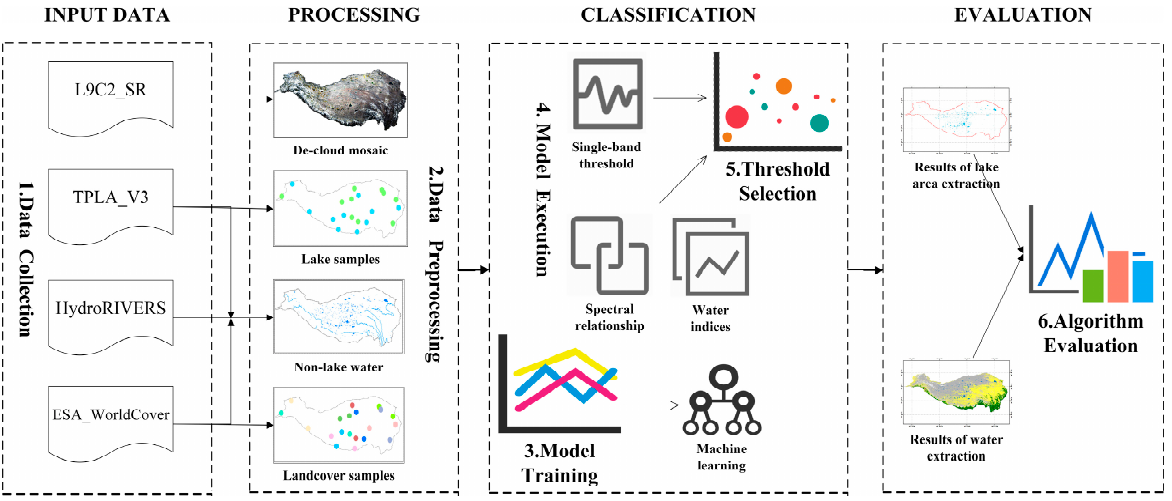
Figure 2. The general workflow of the